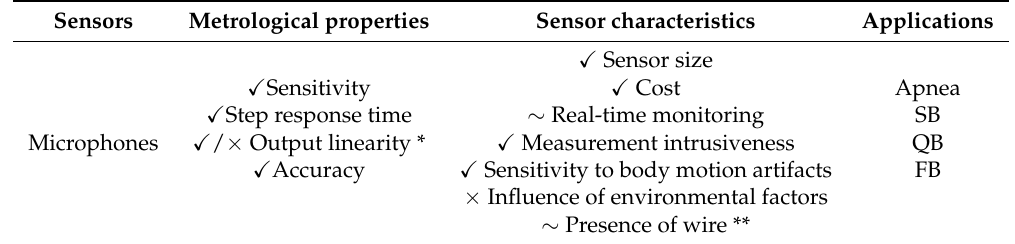
Table 2. Main metrological properties and characteristics of the acoustic sensors used for f R measurement. (cid:88) good to excellent, ∼ sufficient, ×